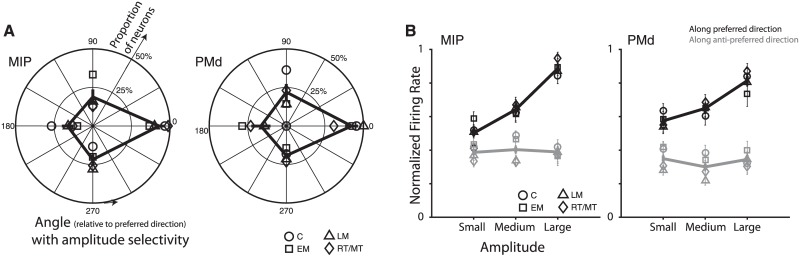
(A) Bias in directions with amplitude-selectivity. Each polar histogram shows the proportion of neurons as a function of ΔPD, the difference in angle between directions with significant amplitude modulation and the preferred direction of the neuron. The two panels correspond to neurons recorded from MIP and PMd under Task 1; different markers correspond to the four epochs of interest. Significant amplitude modulation is tuned towards the preferred direction of the neuron. (B) Bias in amplitude response. Each subpanel shows normalized firing rate response to reaches to small, medium and large amplitude targets of all task-related cells recorded under Task 2. Markers indicate responses for each epoch, and solid lines indicate the pooled average (mean ± SE over neurons shown). Data are separated by responses along the preferred (black line) and anti-preferred (gray line) directions.